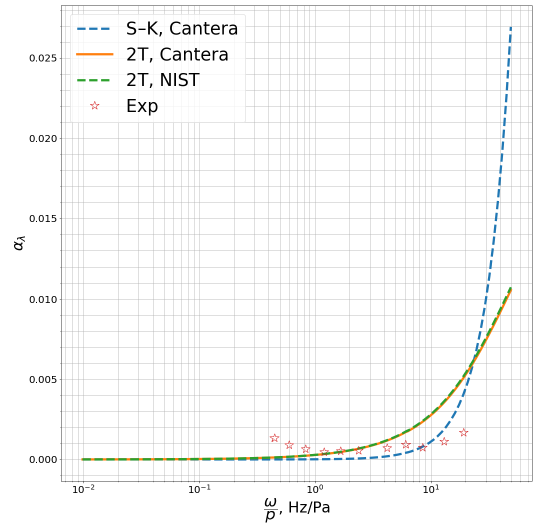
Figure 5. CH 4 . Comparison with experiment [87]. T = 298.15 ◦ C, p = 1 atm. ( Left ) dimensionless attenuation coefficient as a function of ω / p . ( Right ) deviation from the experiment for the 2T model.